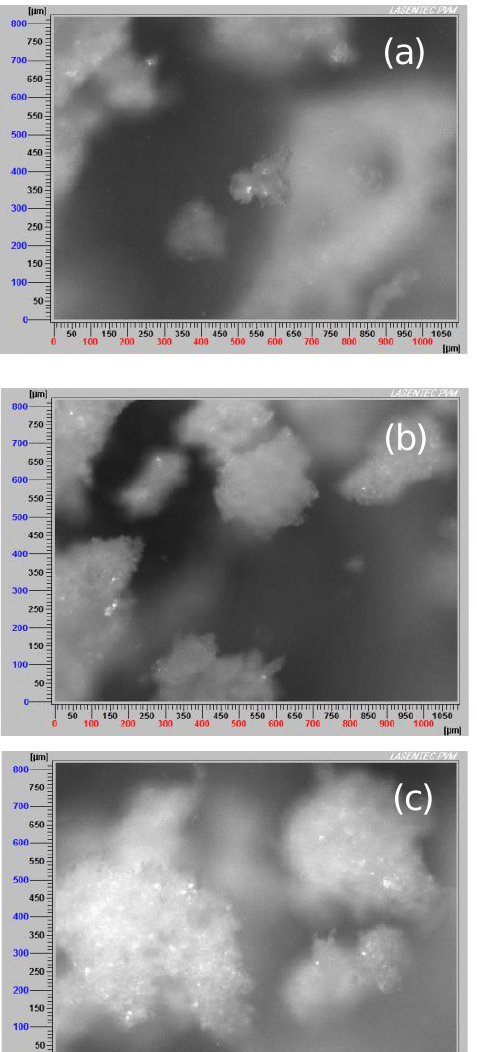
( c ) Figure 12. Variation of compressive yield stress versus volume fraction of kaolin suspensions in IW and SW with flocculant doses ( a ) 50 g/t, ( b ) 75 g/t, and ( c ) 100 g/t. Shear rate 180 rpm, solid concen- tration 5 wt%, flocculation time 15 s, and pH 7. Table 3. Power law parameters ( c and n ) and goodness of fit ( R 2 ) for the compressive yield stress of kaolin suspensions with three flocculant doses in SW and IW. Water